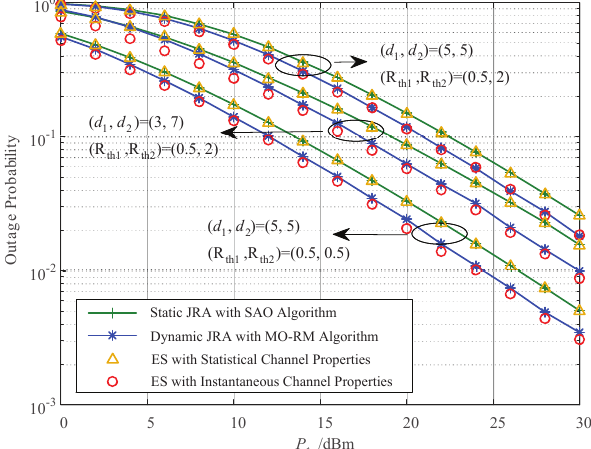
Figure 4. Comparison of the two proposed JRA schemes with the exhaustive search schemes. SAO—successive alternating optimization; MO-RM—multistep optimization with relaxation method; ES—exhaustive